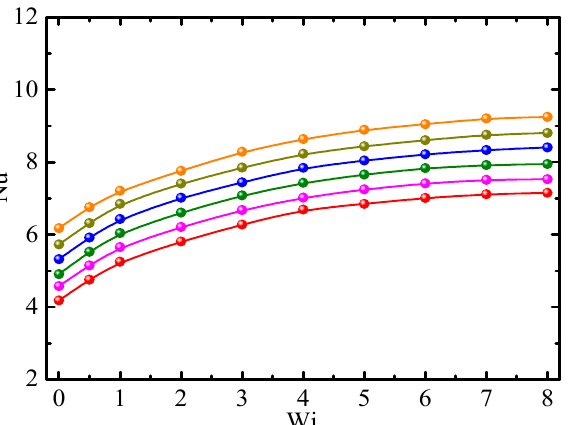
Figure 9. Nusselt number vs. Weissenberg number for different viscosity ratios ( Φ =1.0%, Re = 2.5, α = 0.2). — • —: β 0 = 1.0; — • —: β 0 = 0.9; — • —: β 0 = 0.3; — • —: β 0 = 0.2; — • —: β 0 = 0.1; and — • —: β 0 = 0.